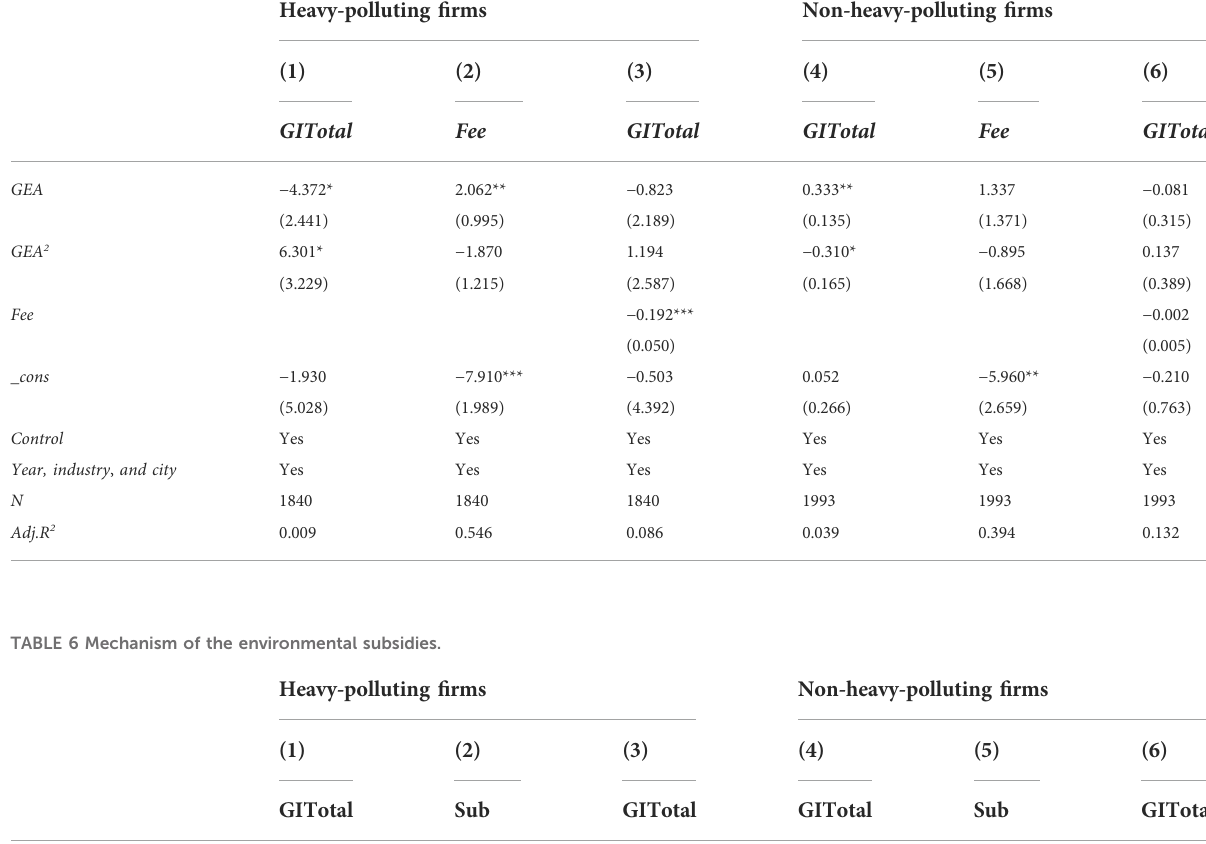
TABLE 5 Mechanism of the environmental related expenses.